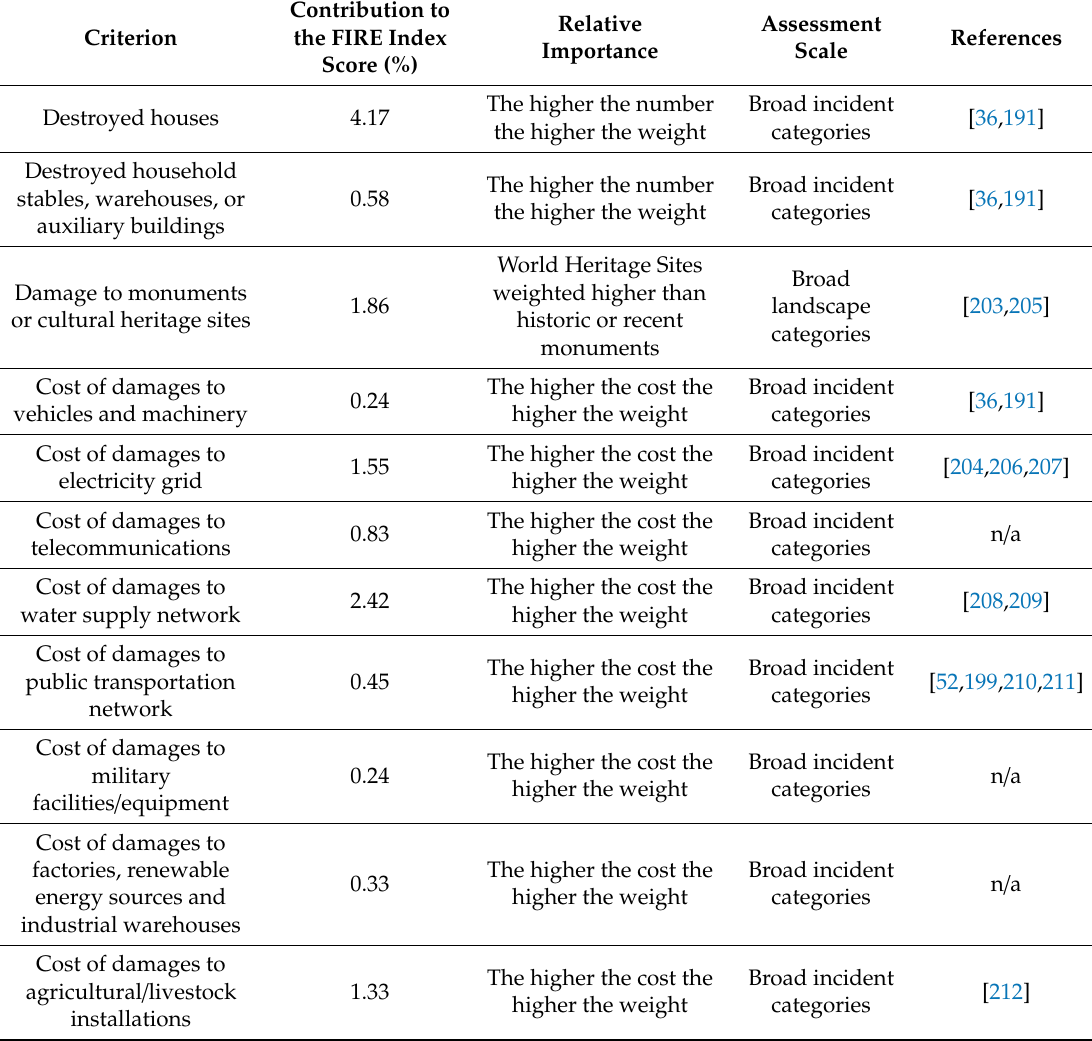
Table 6. Relative importance, assessment scale and relevant literature for each criterion for the destruction and damages to infrastructure fire e ff ects